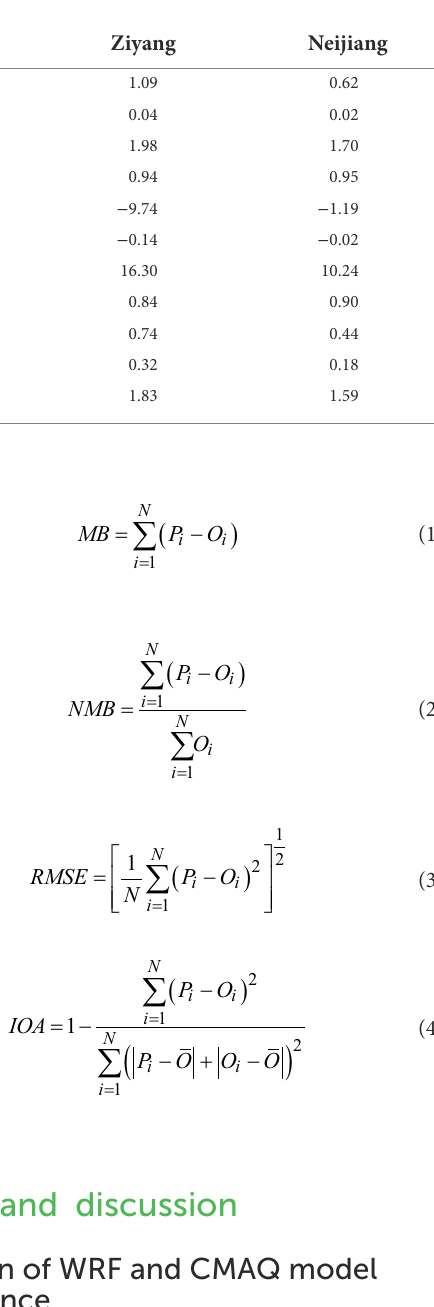
TABLE 1 Statistical metrics of WRF model performance compared with the observed meteorological parameters at Chengdu, Meishan, Ziyang and Neijiang stations from June 1 to 8,